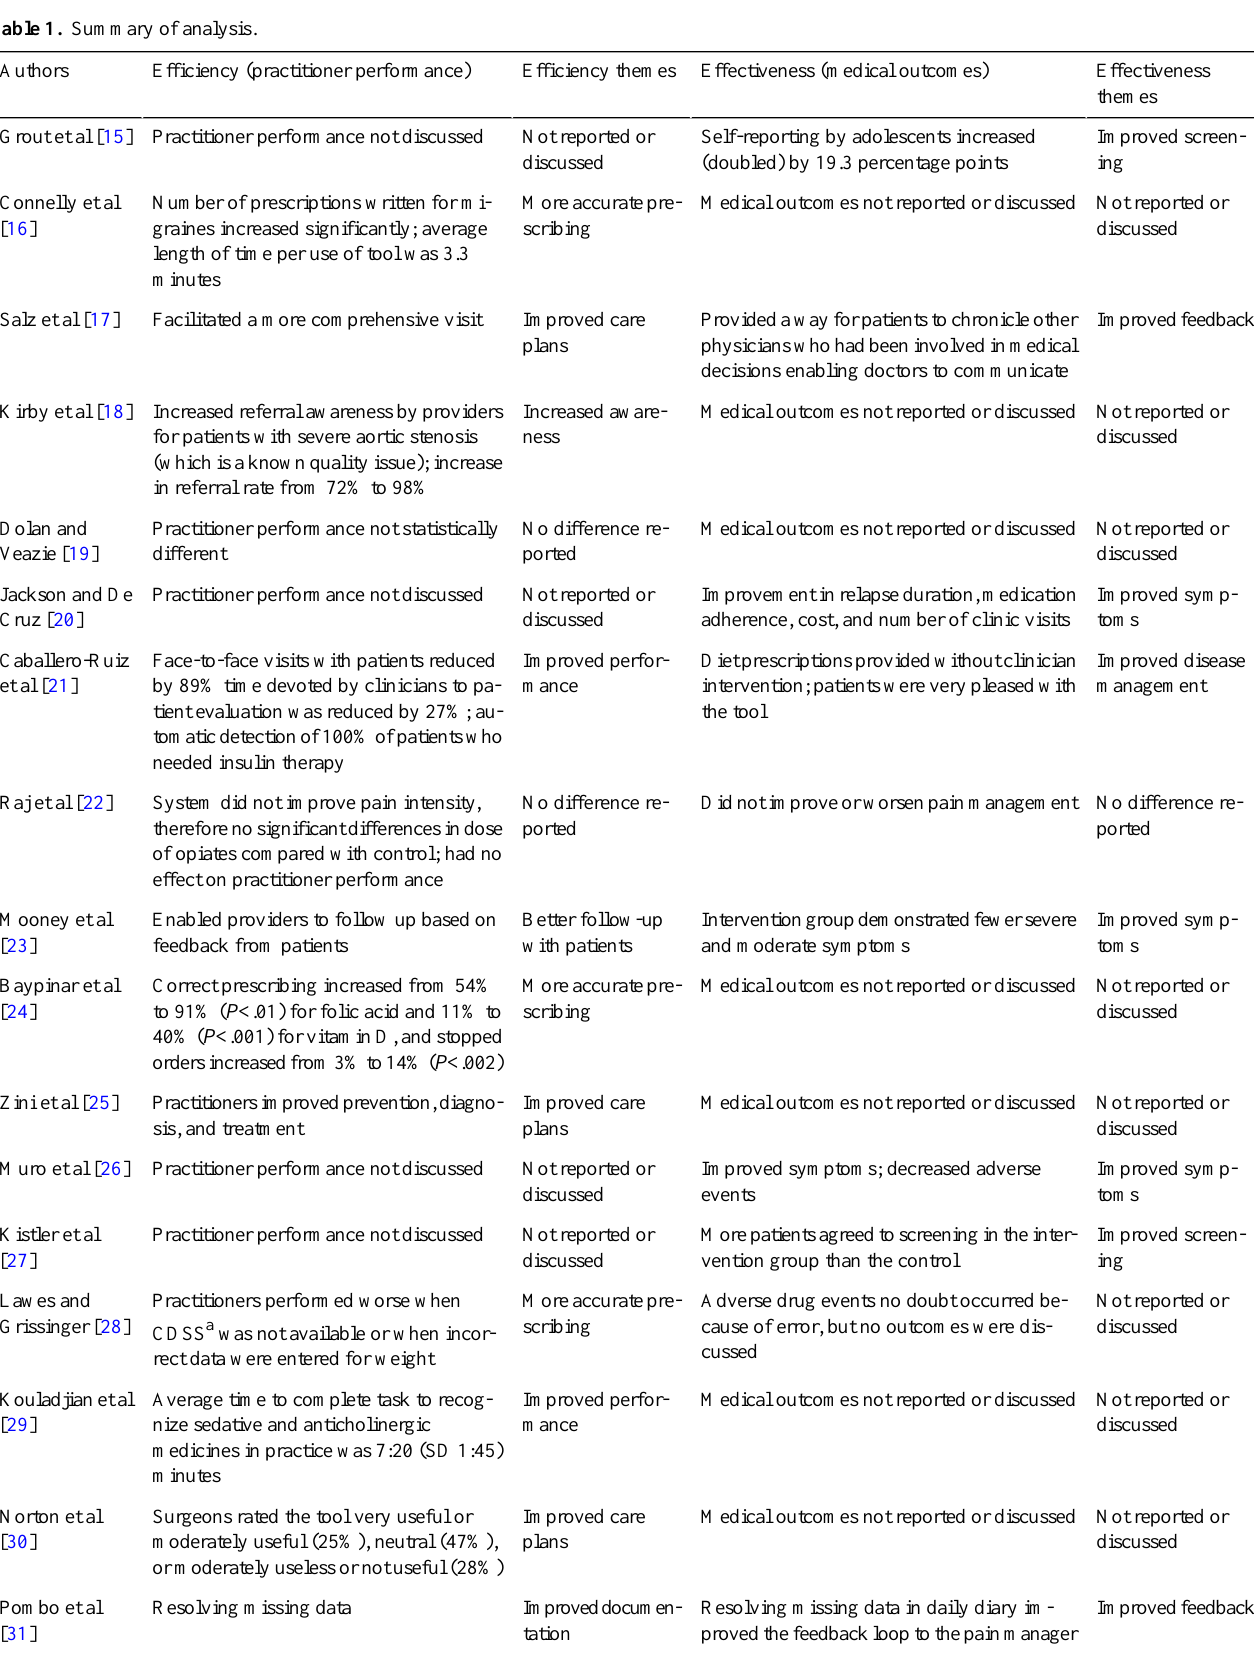
Table 1. Summary of